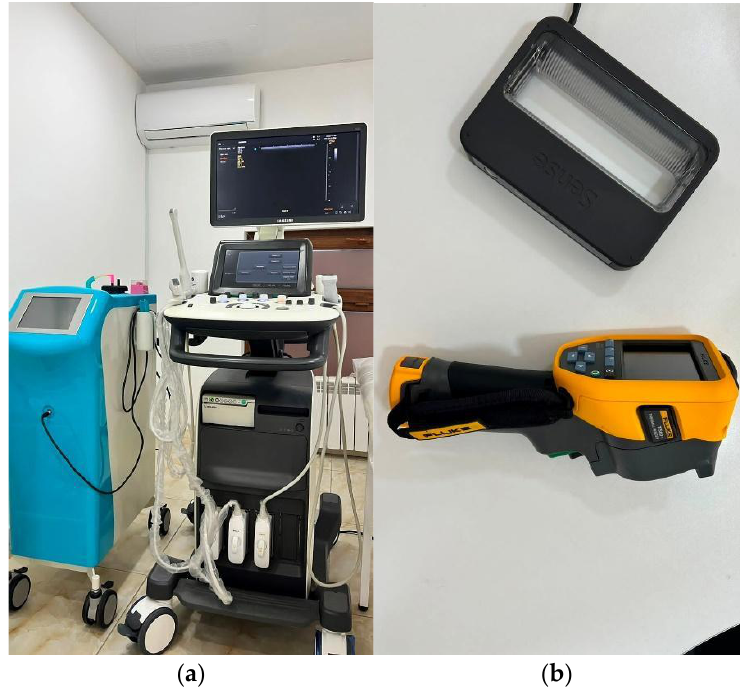
Figure 3. Equipment and space where thermograms from patients were retrieved ( a ) Clinical office for collecting patient data; ( b ) 3D Sense Scanner (on top) and IR camera FLUKE TiS60+ (bottom).